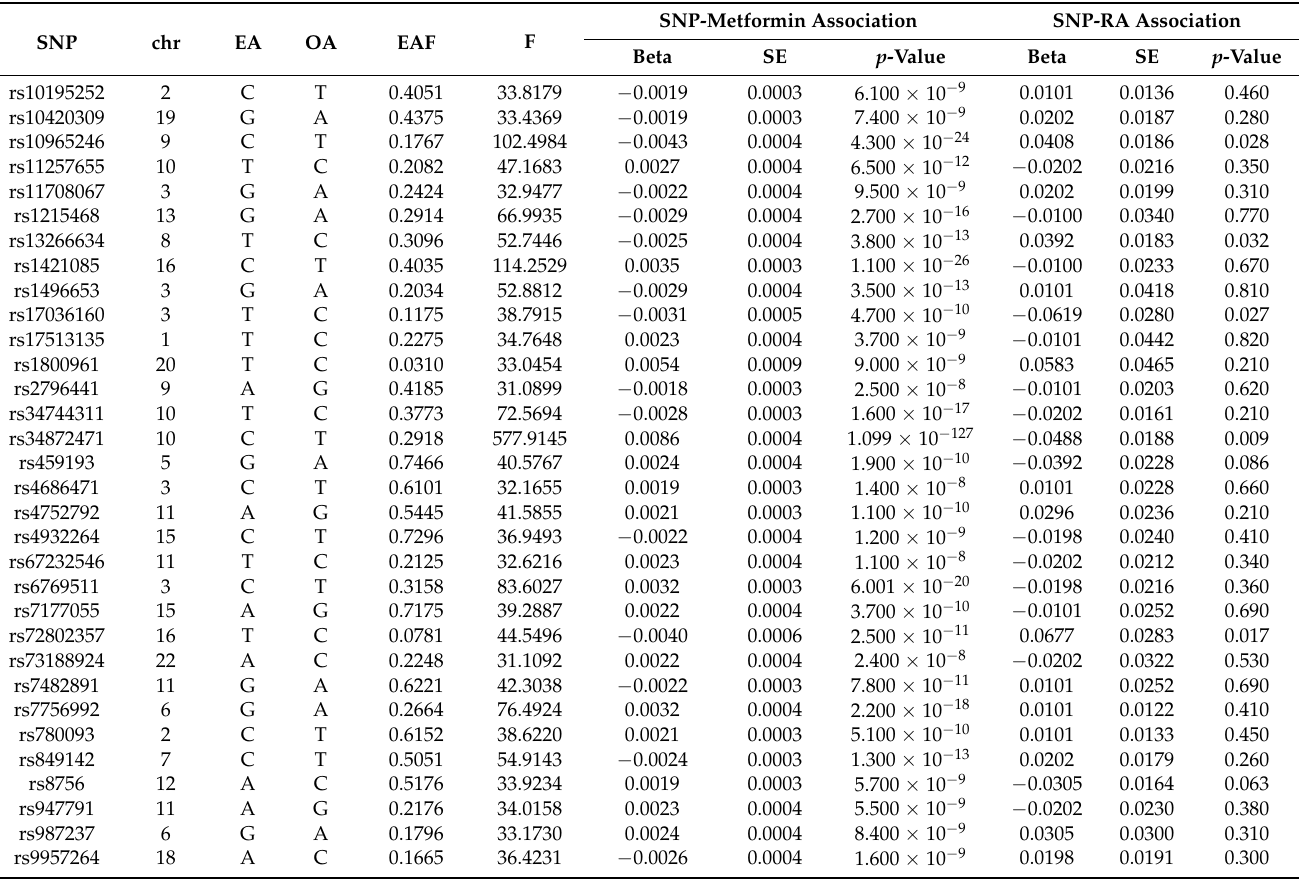
Table 2. The characteristics of SNPs and their genetic associations with metformin and